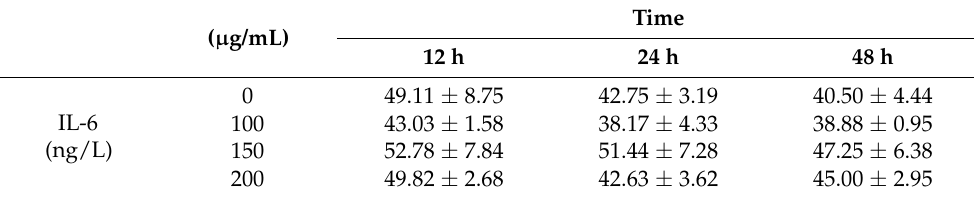
Table 8. Effect of different concentrations of GSP on IL-6 levels in mature adipocytes.